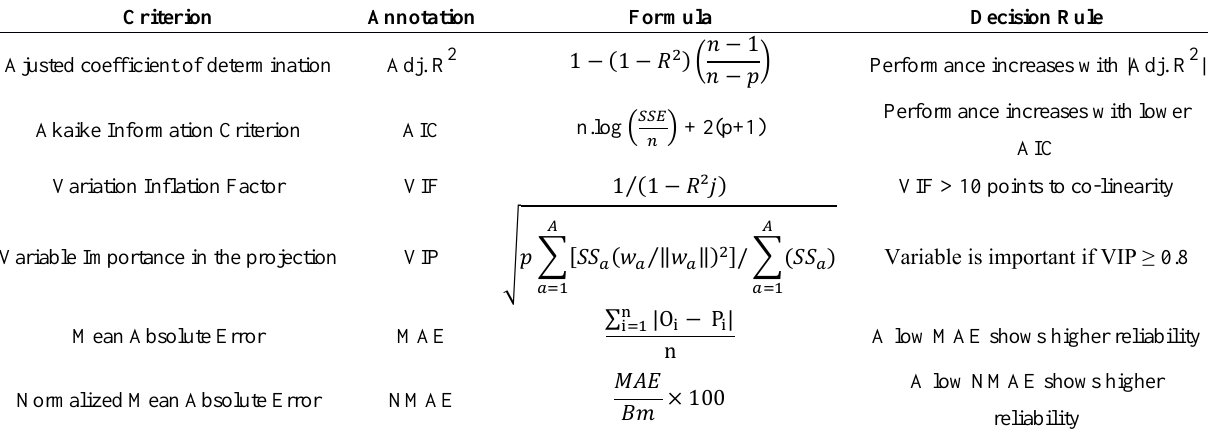
Table 3. Criteria for the variable reduction, model selection, and